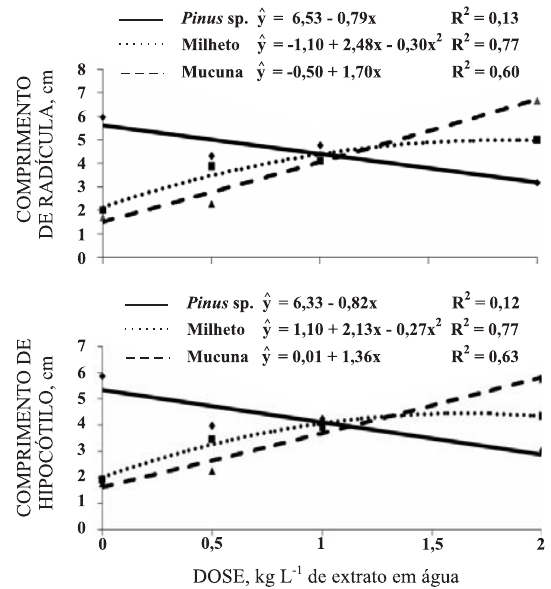
2. Comprimento de radícula e de hipocótilo de milho em função da aplicação das quatro doses de extrato aquoso de Pinus , milheto e mucuna, em condições de germinador, por sete dias a 25 °C; médias de quatro repetições.